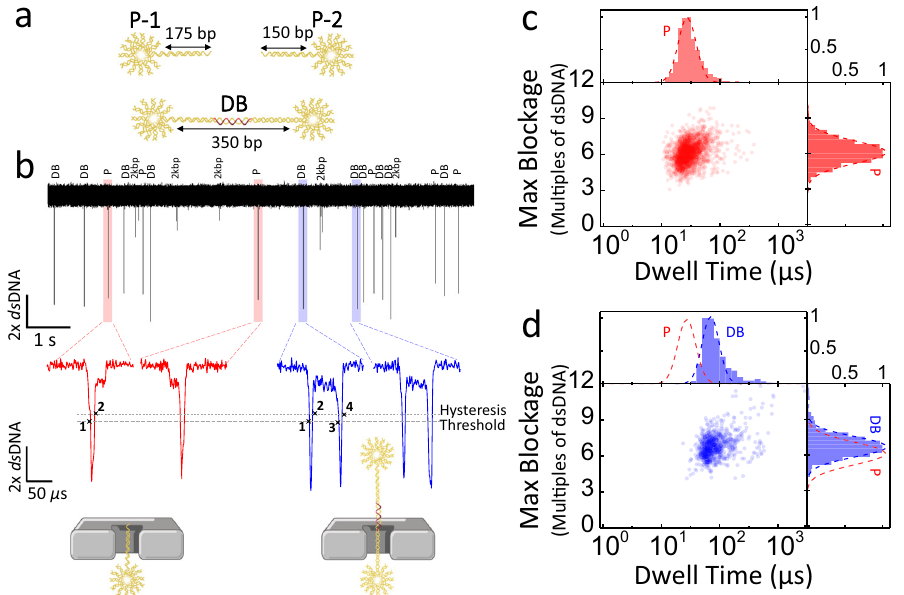
Fig. 2 Nanopore translocation characteristics of the shooting stars probes and the dumbbells. a Artistic representation of the shooting star probes (P-1 and P-2) and the dumbbell (DB). b 10 s current trace of a mixed population of both DNA nanostructures and 2 kbp dsDNA calibrator, with representative current traces showing individual translocation events corresponding to probes (left, red) and dumbbells (right, blue). Scatter plots and histograms of maximum blockage versus dwell time of the shooting star probes ( c ) and dumbbell ( d ). The fi t to the probe distribution (P, red dash line) is overlayed with the dumbbell distribution to facilitate comparison between the two populations. Experiments are performed on an 11.5 nm pore in 3.2 M LiCl pH 8 with an applied bias of 100 mV. Displayed current traces are low-pass Bessel fi ltered at 500 kHz. Source data are available as a Source Data fi